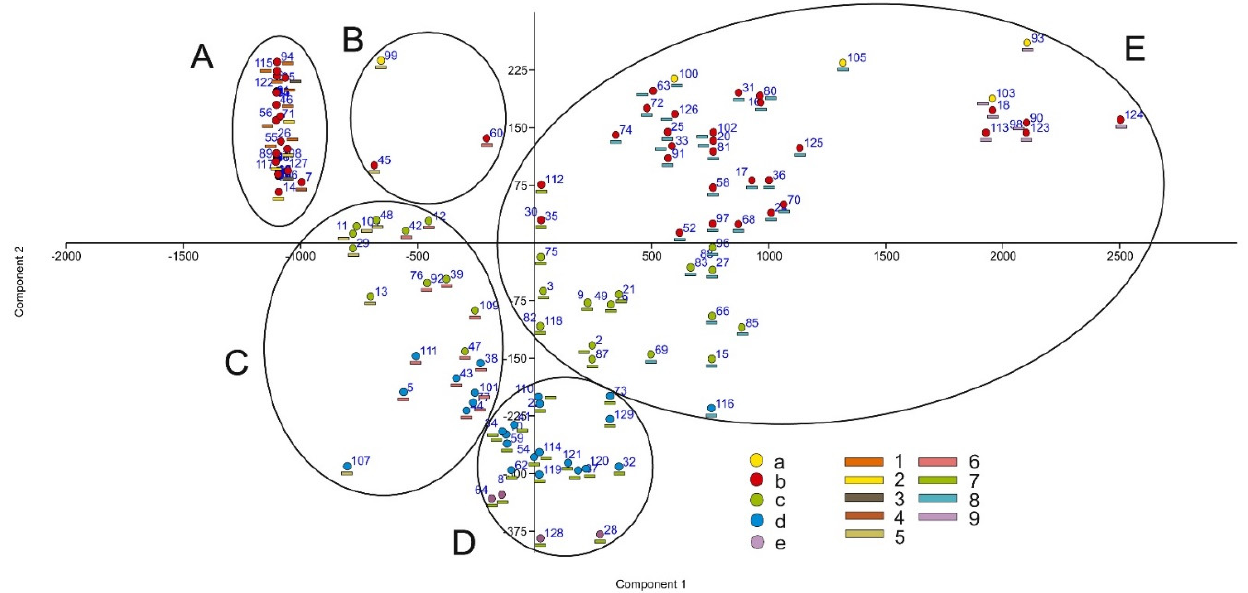
Figure 5. PCA with the localities of useful plants distributed among bioclimatic belts (coloured dots) and ombrotypes (coloured rectangles). Bioclimatic belts: a . infratropical; b. thermotropical; c. meso- tropical; d. supratropical; e. orotropical. Ombrotypes: 1. ultra − hyperarid; 2. hyperarid; 3 . arid; 4 . semiarid; 5. dry; 6. subhumid; 7. humid; 8. hyperhumid; 9. ultra − hyperhumid.